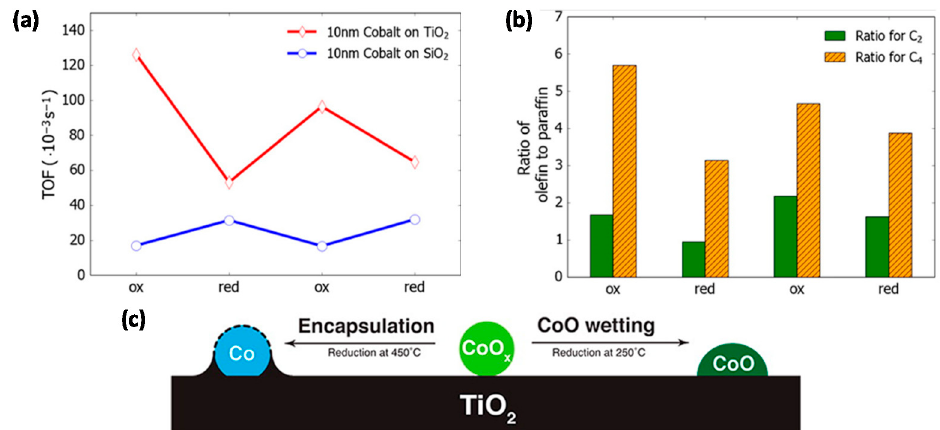
Figure 4. ( a ) TOF values for Co/TiO 2 and Co/SiO 2 FTS catalysts as a function of the oxidation state. ( b ) Olefin to paraffin ratios of C 2 and C 4 hydrocarbons for the Co/TiO 2 FTS catalyst. ( c ) Schematic representation of the reversible TiO 2 encapsulation of Co in Co/TiO 2 .“Ox” denotes oxidized Co, “red” reduced Co. Reduced Co was obtained via a H 2 treatment. (H 2 : 10% ( V / V ), balance Ar) at 450 °C for 1 h, oxidized Co upon O 2 treatment (O 2 : 20% ( V / V ), balance Ar) at 350 °C and maintained in a H 2 atmosphere at 250 °C. Reaction conditions for ( a ) and ( b ): T = 250 °C, P = 5 atm, CO/H 2 = 1/2, 24 h. Adapted with permission from Ref. [92]. Copyright 2014 American Chemical Society.